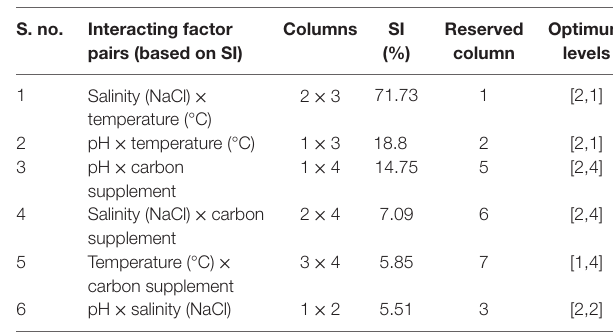
TaBle 6 | automated test for presence of interaction